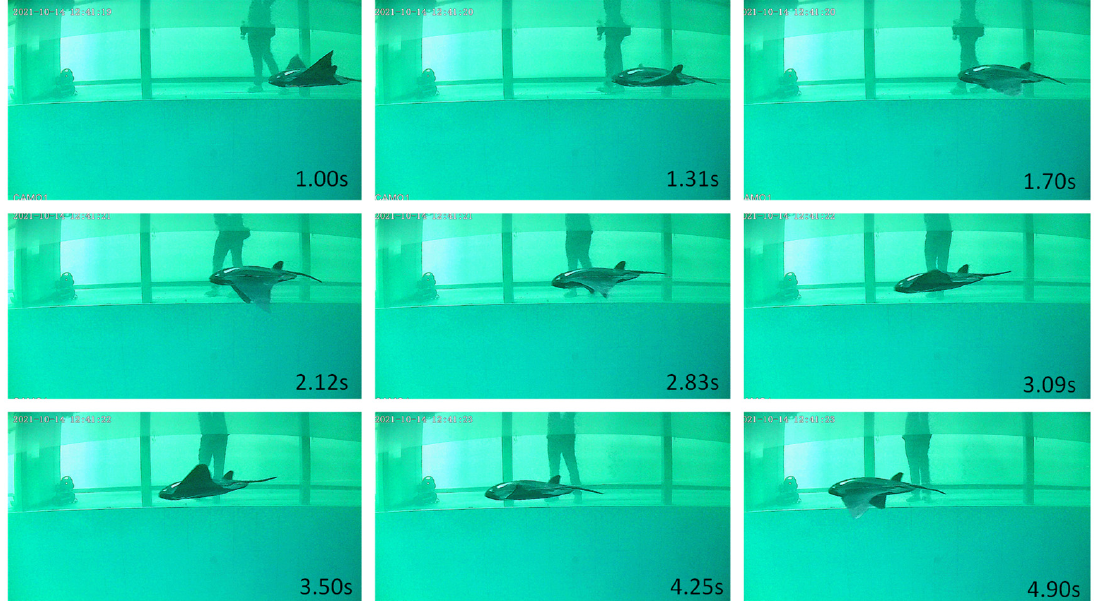
Figure 8. Forward swimming motion sequence frame diagram in the swimming experiment.